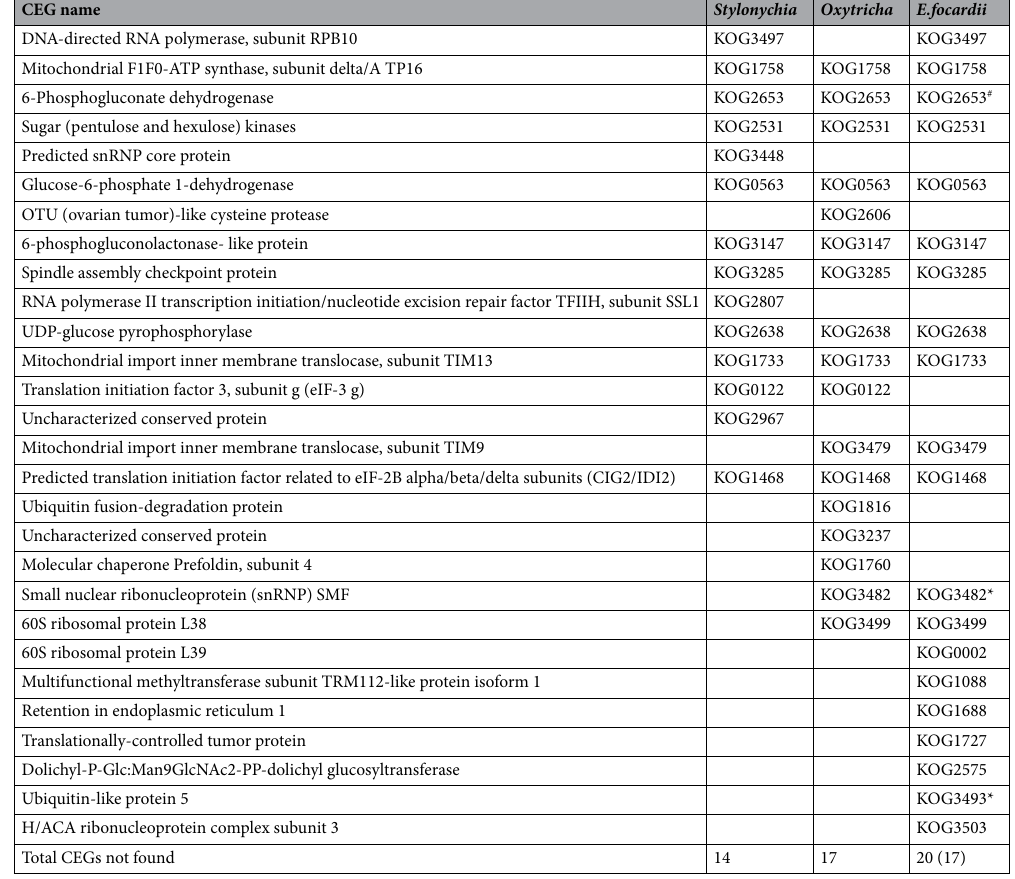
Table 3. CEGs missing from alignment results using default CEGMA criteria. # Found into a contig without telomeres set (with %GC > 45). *Found into the assembly set but not into the genes predicted